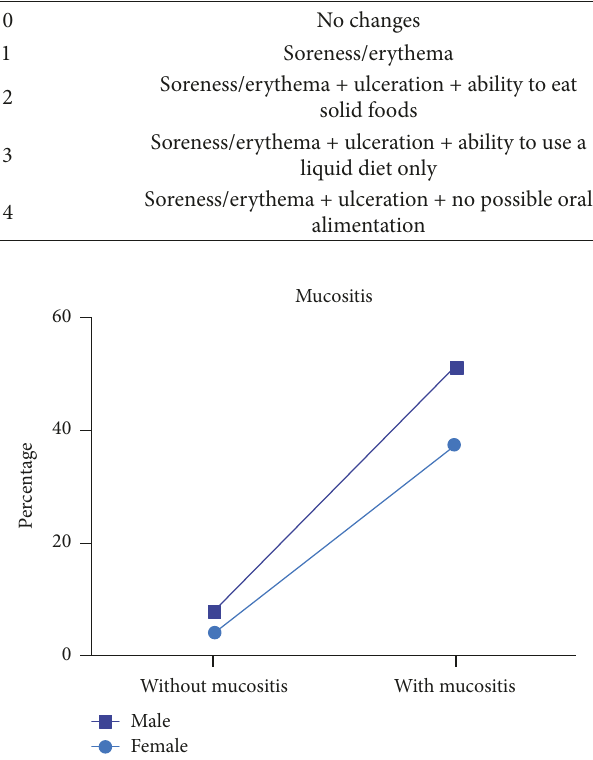
Figure 1: Distribution of patients with and without mucositis ac- cording to gender, expressed as percentage of